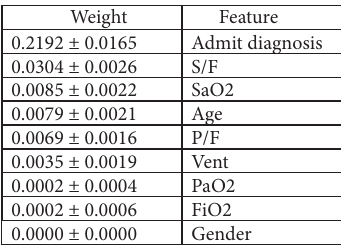
Figure 4: Feature importance ranked using permutation importance in a descending order. The weight reflects quantitative reduction in model performance with reshuffling of that column. PaO 2 : partial pressure of oxygen; FiO 2 : fraction of inspired oxygen; SaO 2 : oxygen saturation; P/F: PaO 2 and FiO 2 ratio; S/F: SaO 2 and FiO 2 ratio; Vent: mechanical